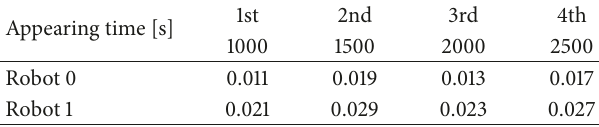
Table 7: Moving velocity of added objects.